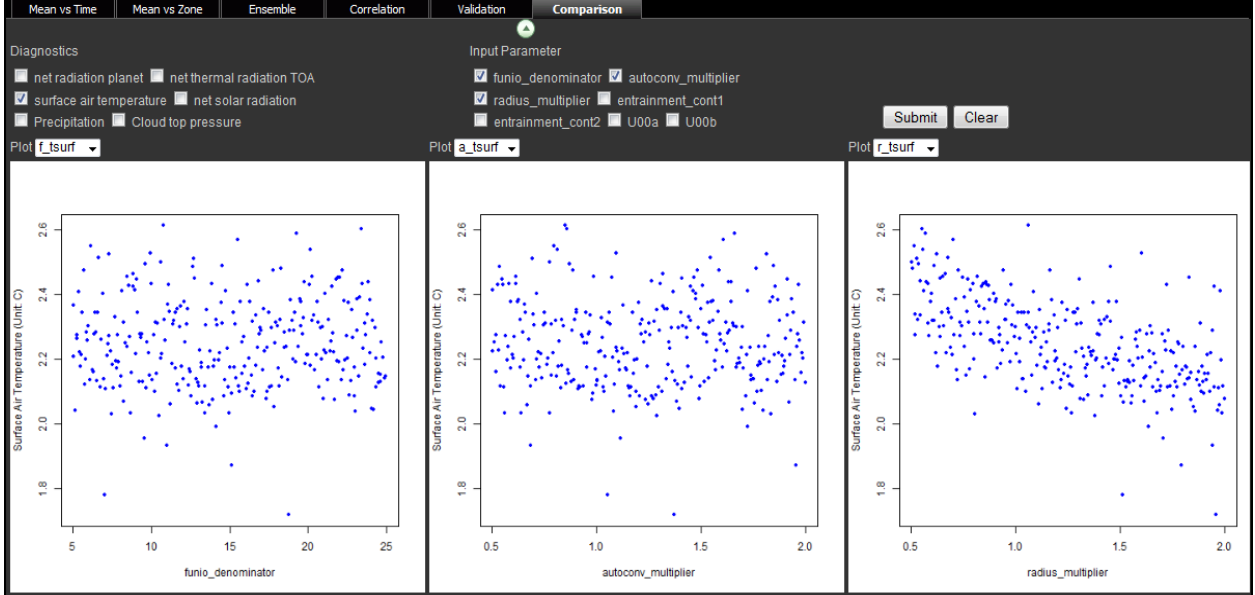
Figure 10. Interface for comparing model inputs and